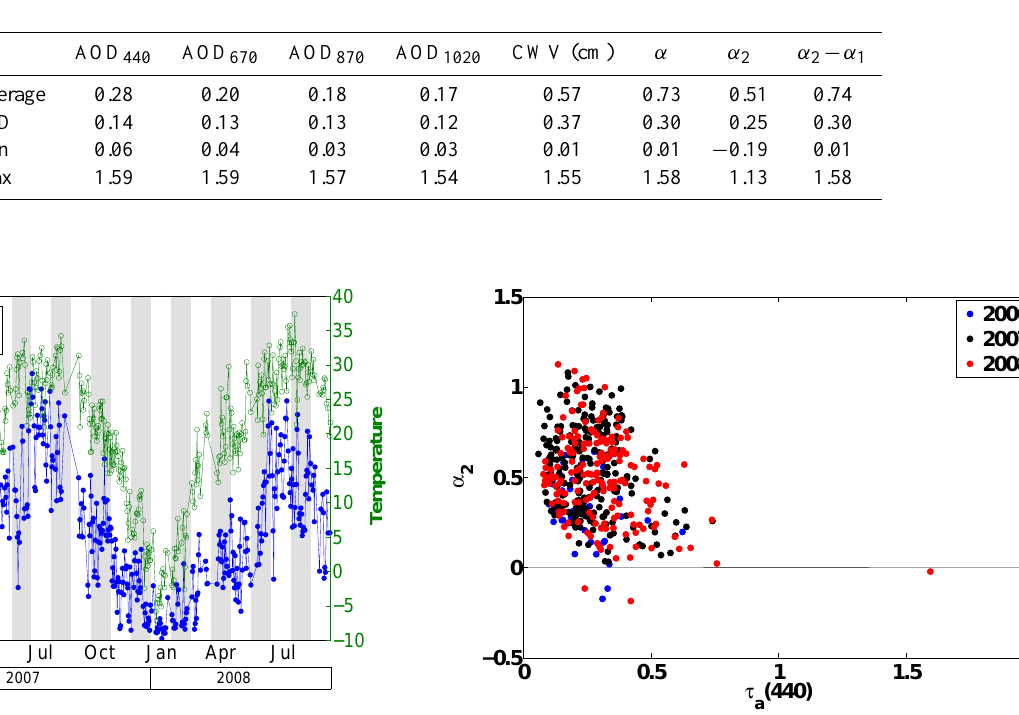
Table 2. AOD statistics for the 2-year data series in Zanjan in all 4 AOD channels, CWV at 936nm, α , α 2 and α 2 − α 1 : the average, standard deviation (STD), minimum, and maximum. Total number of days with valid data: 448.